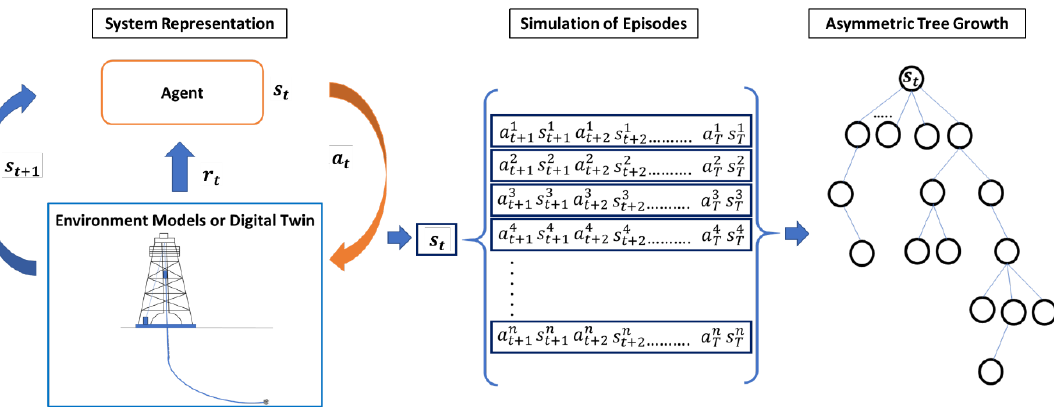
Figure 2. Asymmetric tree growth using simulation-based search algorithms. An action 𝑎 𝑡 by the agent in the environment (observed by the agent to be in a state 𝑠 𝑡 ) results in an immediate reward 𝑟 𝑡 and a new observed state 𝑠 𝑡+1 . agent in the environment (observed by the agent to be in a state s t ) results in an immediate reward r t and a new observed state s t + 1